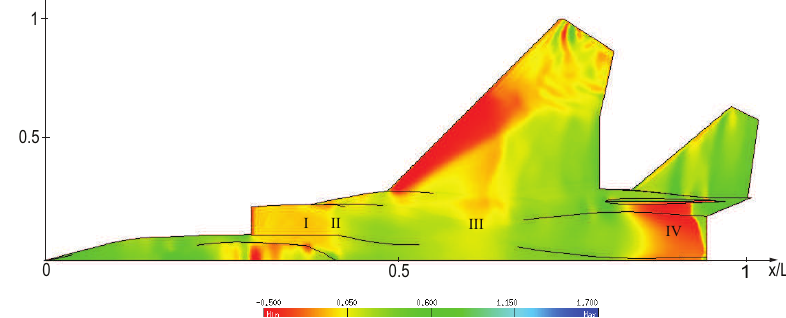
Figure 14. Iso-contours of pressure coefficient in the upper surface of the F15